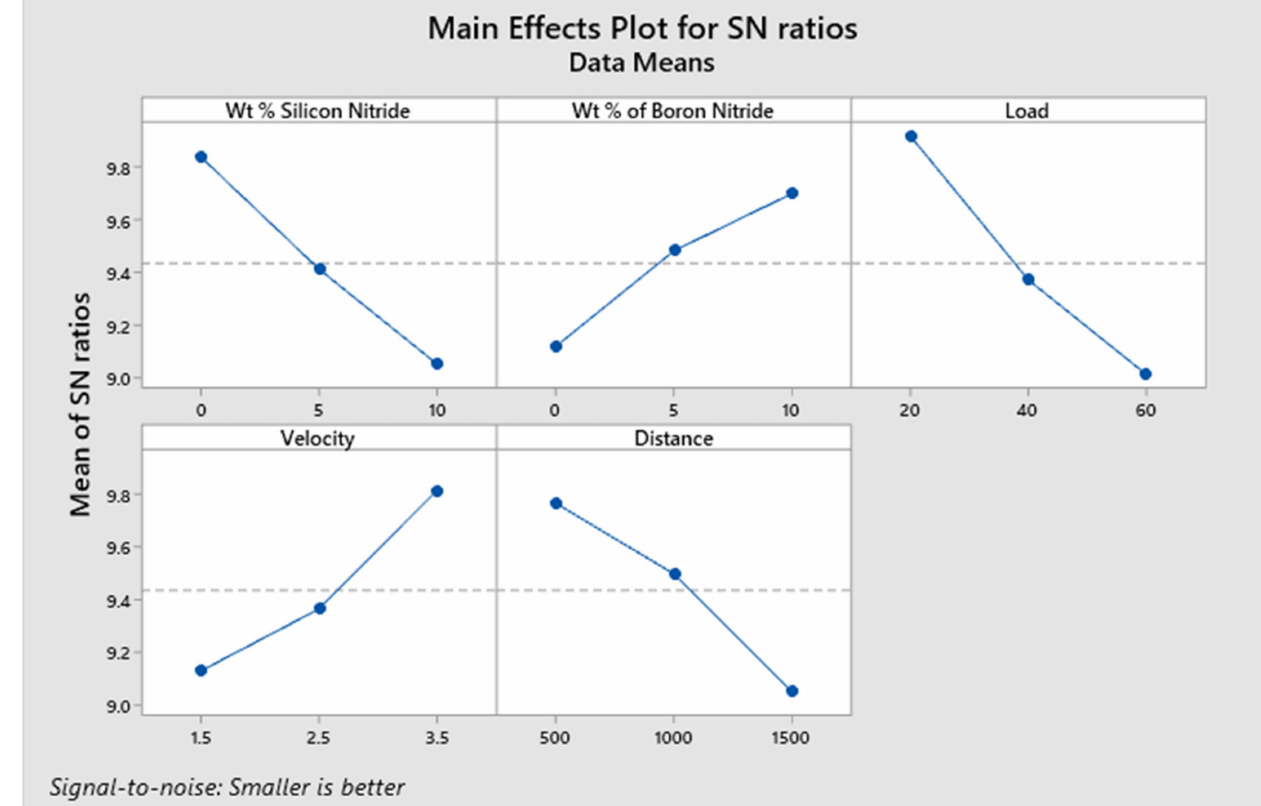
Figure 5. Effect of independent process parameters on